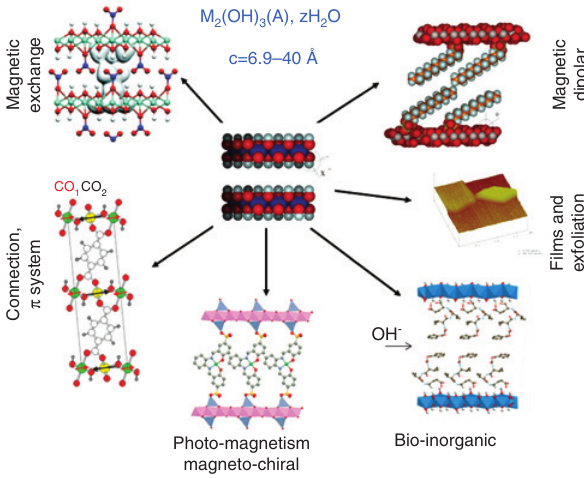
Scheme 1: Schematic summary of our approach for the realization of magnetic and bifunctional lamellar hybrid materials based on simple hydroxides of transition metals [35,